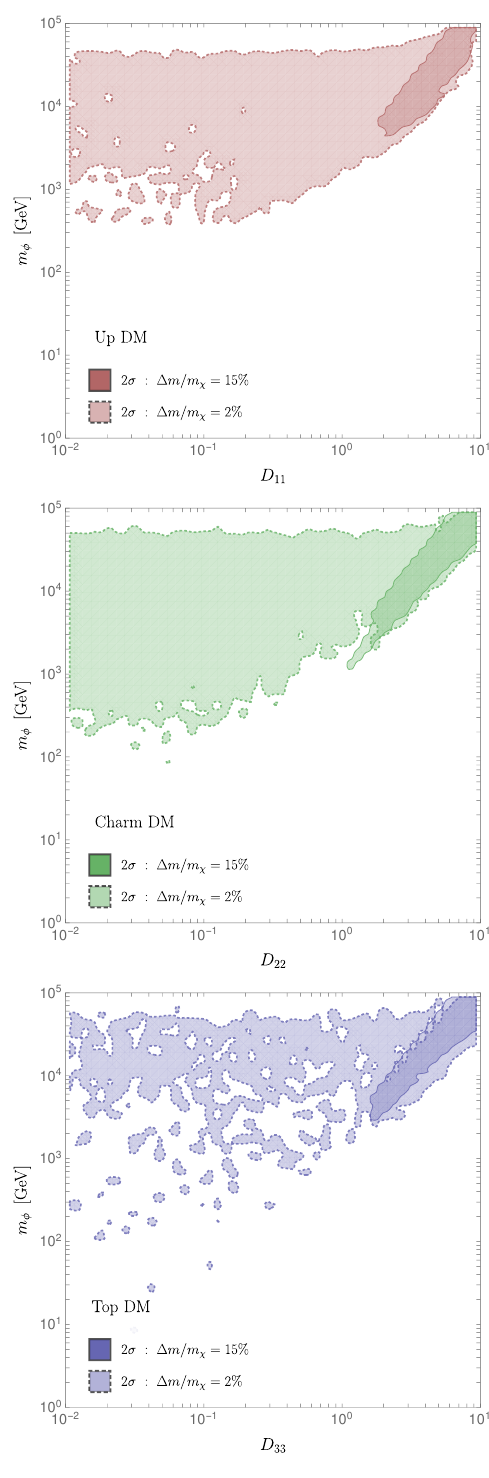
Figure 14 . Credible regions (2 (cid:27) contours) in the m plane (left) and D (right) where (cid:31) (cid:0) m (cid:30) ii (cid:0) m (cid:30) the DM is (cid:31) (top), (cid:31) (middle) or (cid:31) (bottom). Two values of a mass splitting are chosen, shown 1 2 3 with solid and dashed contours respectively.